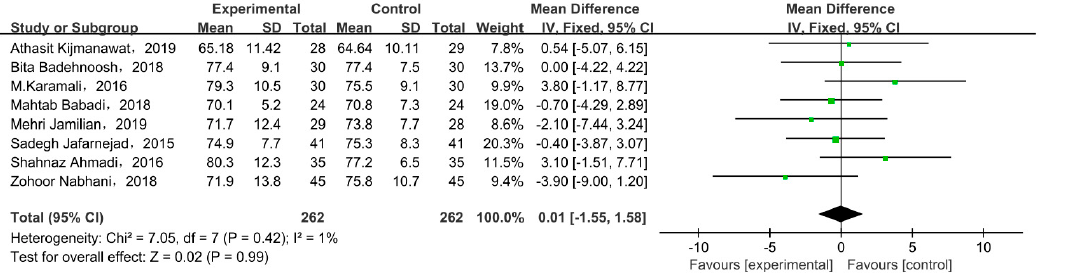
Figure 6. Effect of probiotic supplementation on weight at end of trial in pregnant women with GDM.